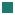
Alkaline titration of the Schiff base of multiple EC Glu mutants and WT.(A) Representative difference spectra (pHi–pH6) of 3Glu in 1 M KCl (for pH values i = 9 to 12.5), at room temperature. The cross over point at 515 nm reflects the transition from the basic (purple in 1 M KCl) to red spectral form. (B) Representative difference spectra (pHi–pH6) of 2Glu in 150 M KCl (for pH values i = 6 to 13.2), at room temperature. Insets in A and B represent plots of the absorption changes at 470 nm and 370 nm, as a function of the pH. The apparent pKa of SB, at 12.8 and 12.3 for 2Glu (150 mM KCl) and 3Glu (1 M KCl), respectively, were obtained from the best fit of ΔA at 370 nm vs pH using the Henderson-Hasselbach equation. (C) Plots of the absorption changes at 570 nm as a function of pH,for WT (■) and 2Glu (■) in 150 mM KCl, and 3Glu (■, ●) and 4Glu (■, ●) in 150 mM and 1 M KCl, respectively, at room temperature. Continuous lines are empirically drawn for a visual help and do not represent a fit of the data.